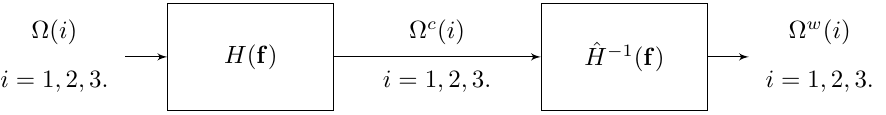
Figure 2. Simulation of correlated and decorrelated lexicographic single-look complex (SLC) scattering vectors.